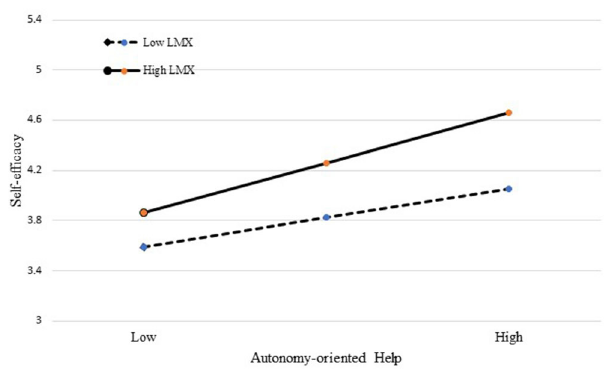
FIGURE 2 | The interactive effect of autonomy-oriented help and group-level LMX on self-efficacy.